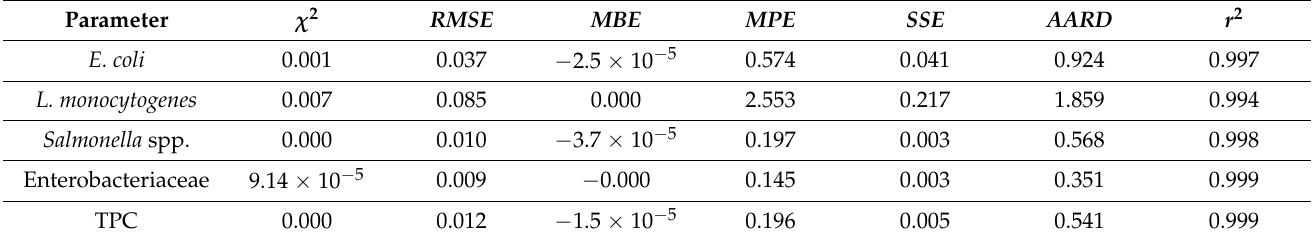
Table 8. The goodness-of-fit tests for the developed ANN